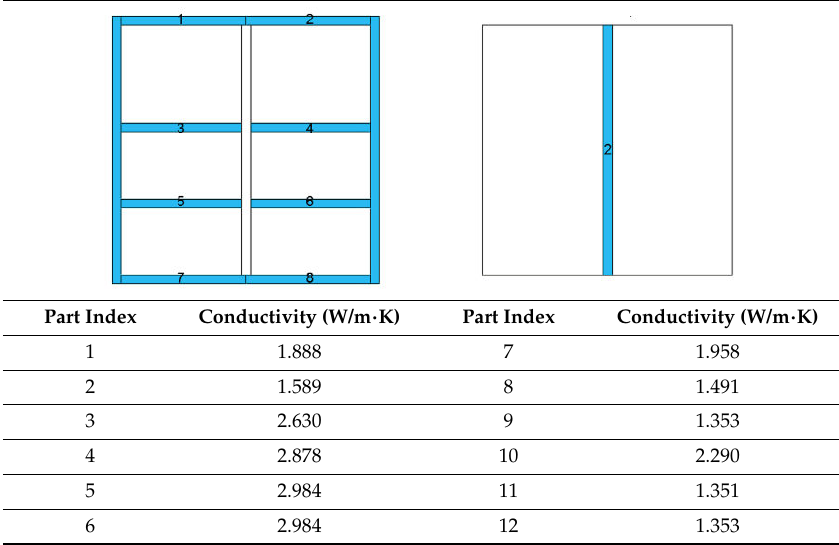
Table 11. Frame Conductivities of SDSW calculated by LBNL THERM